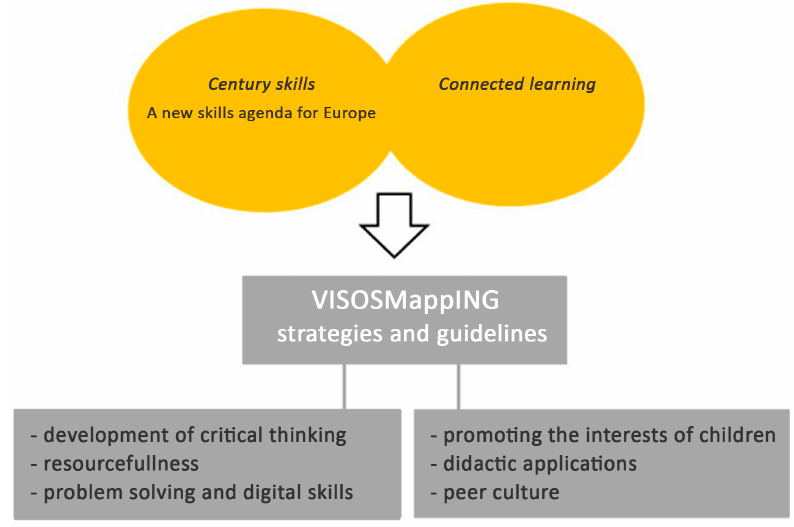
Figure 2. The project structure: the strategy and guidelines of VISOSMappING.